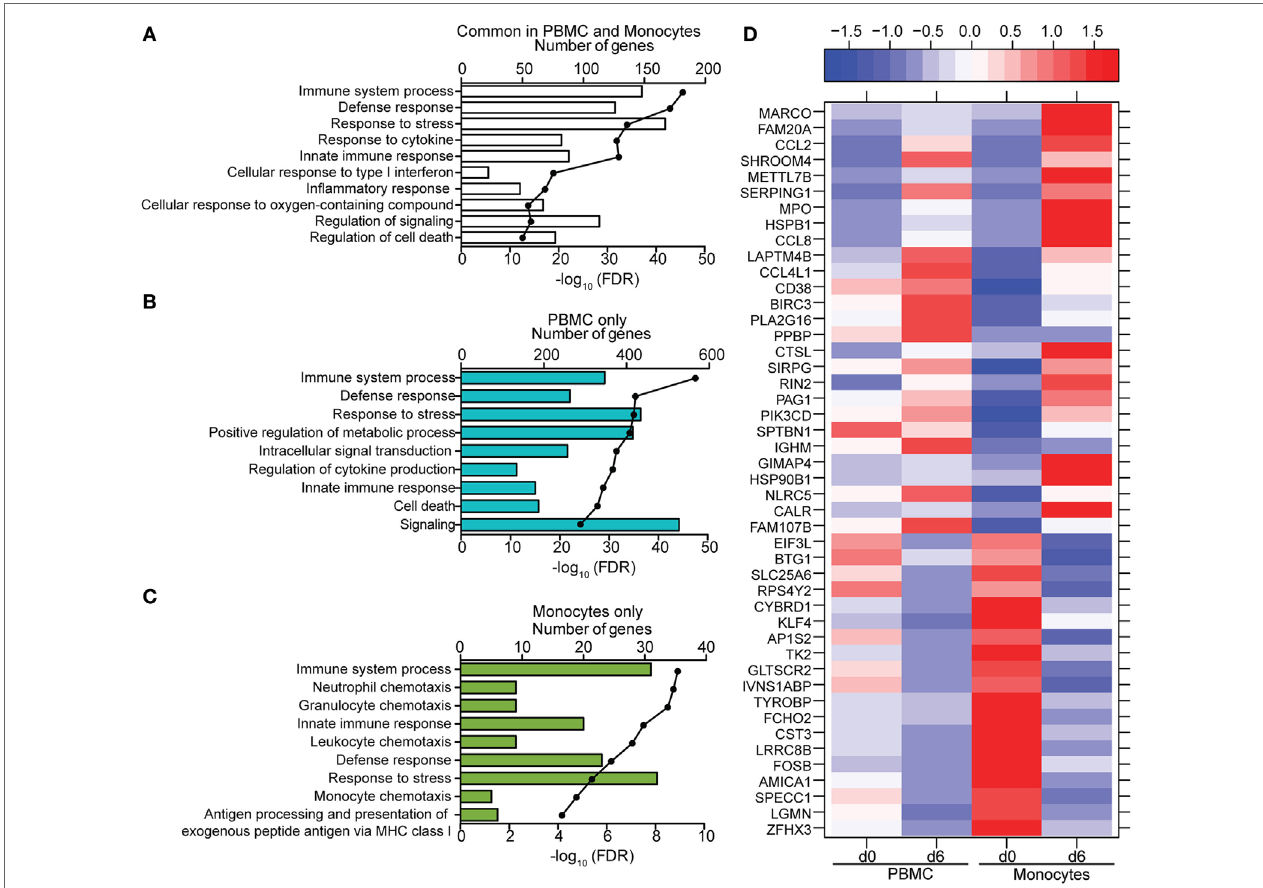
FigUre 7 | Comparison of transcriptional profiles between peripheral blood mononuclear cells (PBMC) and monocytes 6 DPI. (a–c) Functional enrichment of differentially expressed genes (DEGs) detected in both monocytes and PBMC (a) , PBMC only (B) , or monocytes only (c) ; horizontal bar graphs represent number of genes that mapped to each Gene Ontology term listed while line graph represents false discovery rate (FDR)-corrected p -value. (D) Heatmap representing gene expression (shown as absolute normalized RPKM values) of the 46 DEGs that were only detected in monocytes 6 DPI; corresponding RPKM values in PBMC are shown for comparison; range of colors is based on scaled and centered RPKM values of the entire set of genes (red represents increased expression while blue represents decreased expression); each column represents the median RPKM values on each day for each